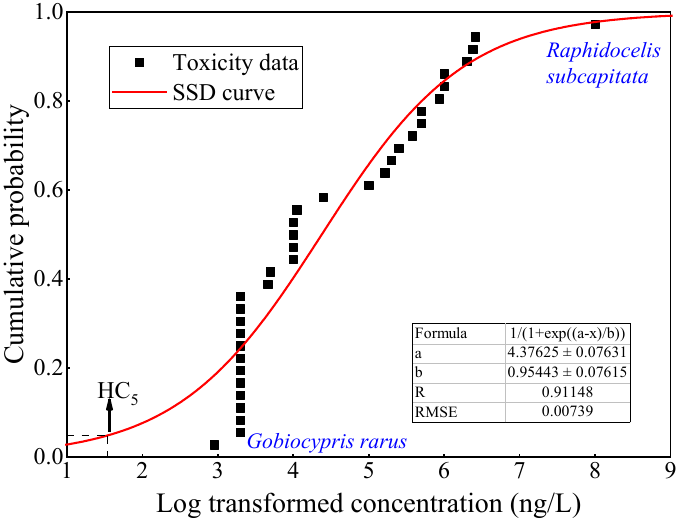
Figure 3. Species sensitivity distributions (SSD) for carbamazepine.